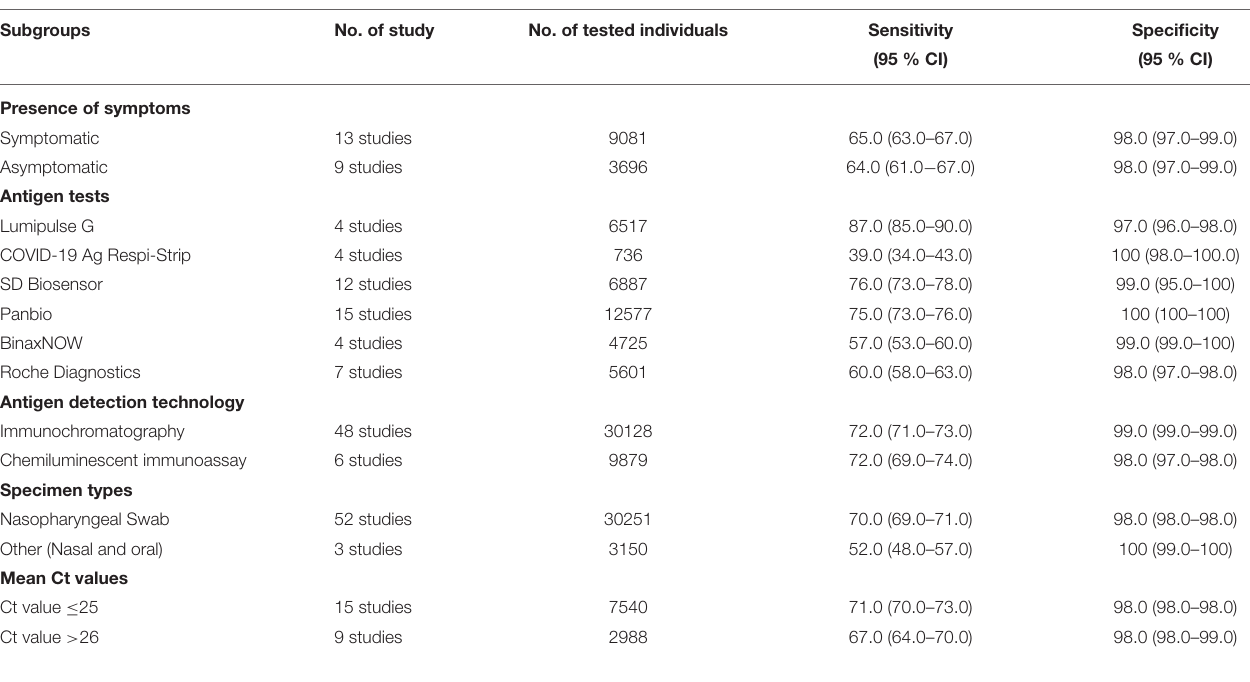
TABLE 3 | Pooled sensitivity and specificity among subgroups of